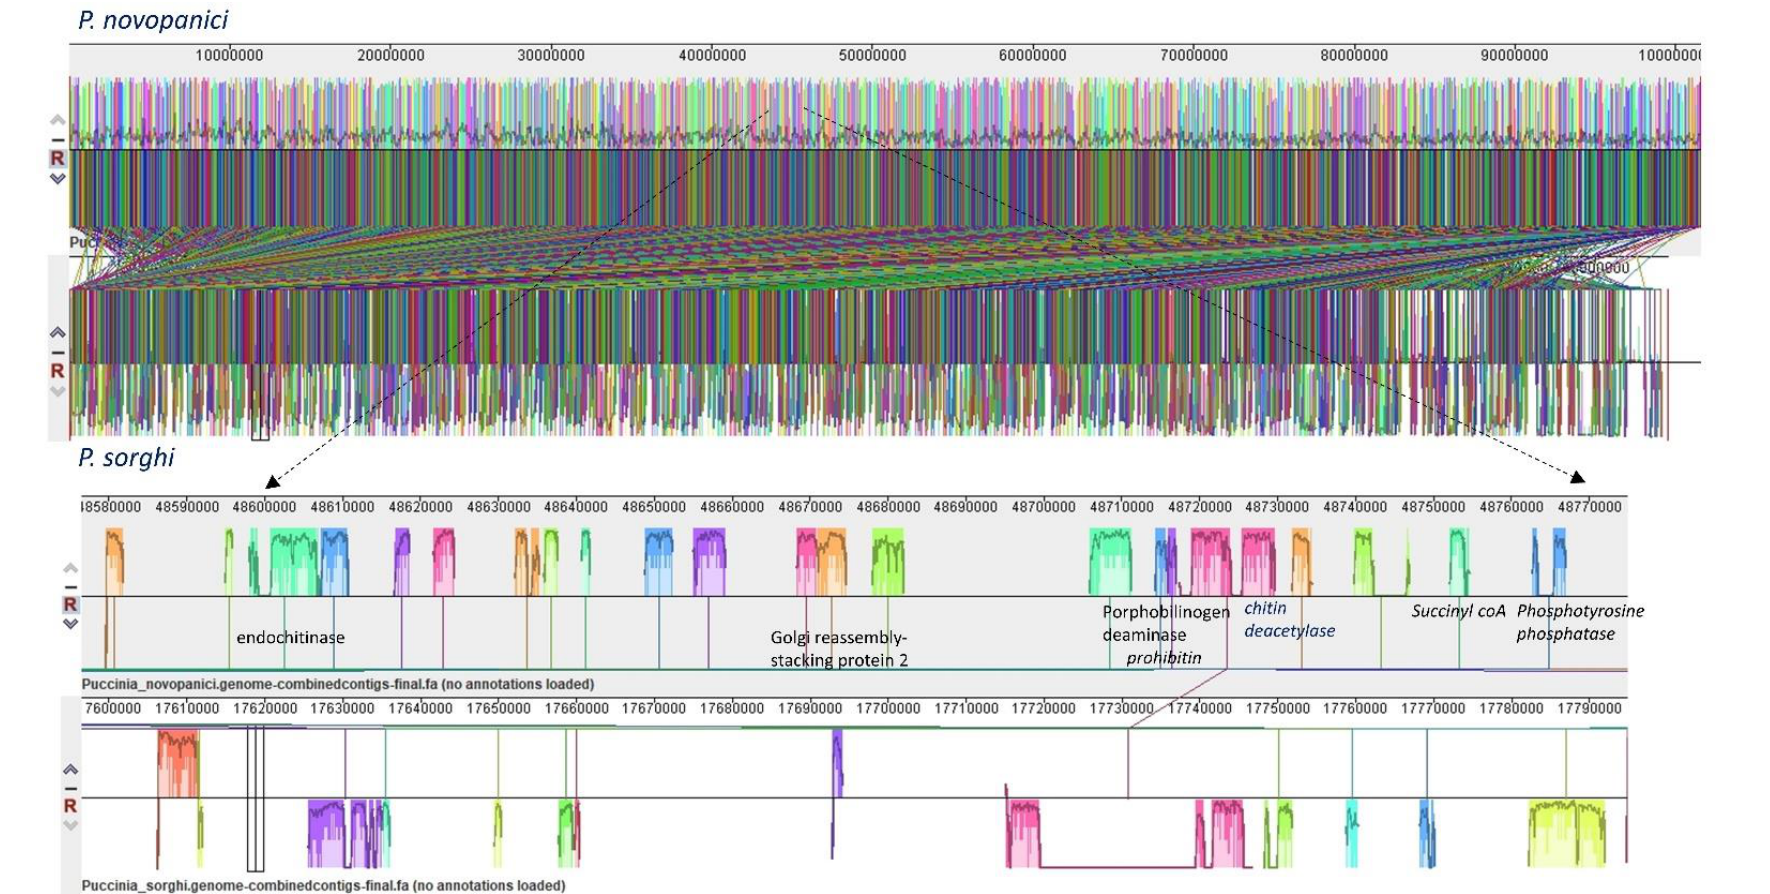
Figure 2. Synteny and collinearity of P. novopanici genome with P. sorghi . The figure represents a synteny plot generated by Progressive Mauve between P. novopanici (top panel) and P. sorghi (bottom panel). Colored blocks represent locally collinear blocks (LCBs) between P. novopanici and P. sorghi . The crisscross lines between two genomes are the LCB strikethrough lines. There are 6251 LCBs with a seed weight of 39 for anchored positions. The expanded view shows the LCBs in those particular regions of the genomes.